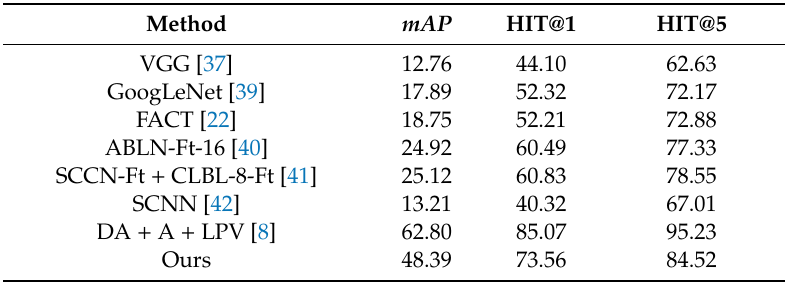
Table 3. Comparison of our approach with other approaches on